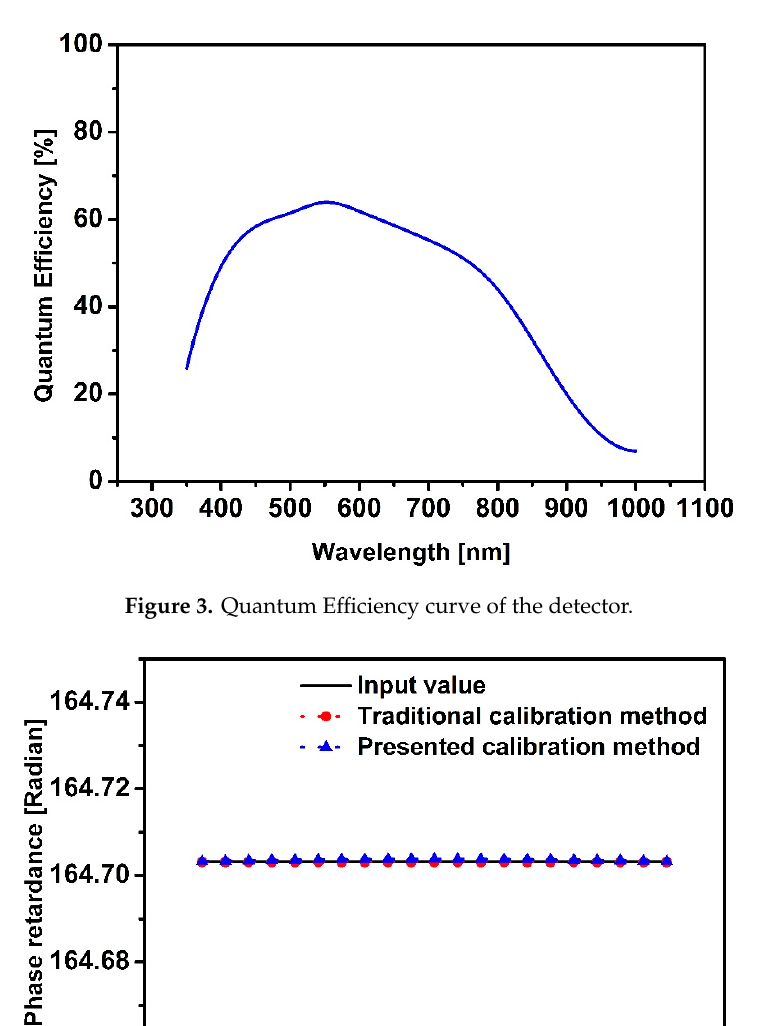
Figure 4. Input values and calibration results of ϕ 2 ( σ